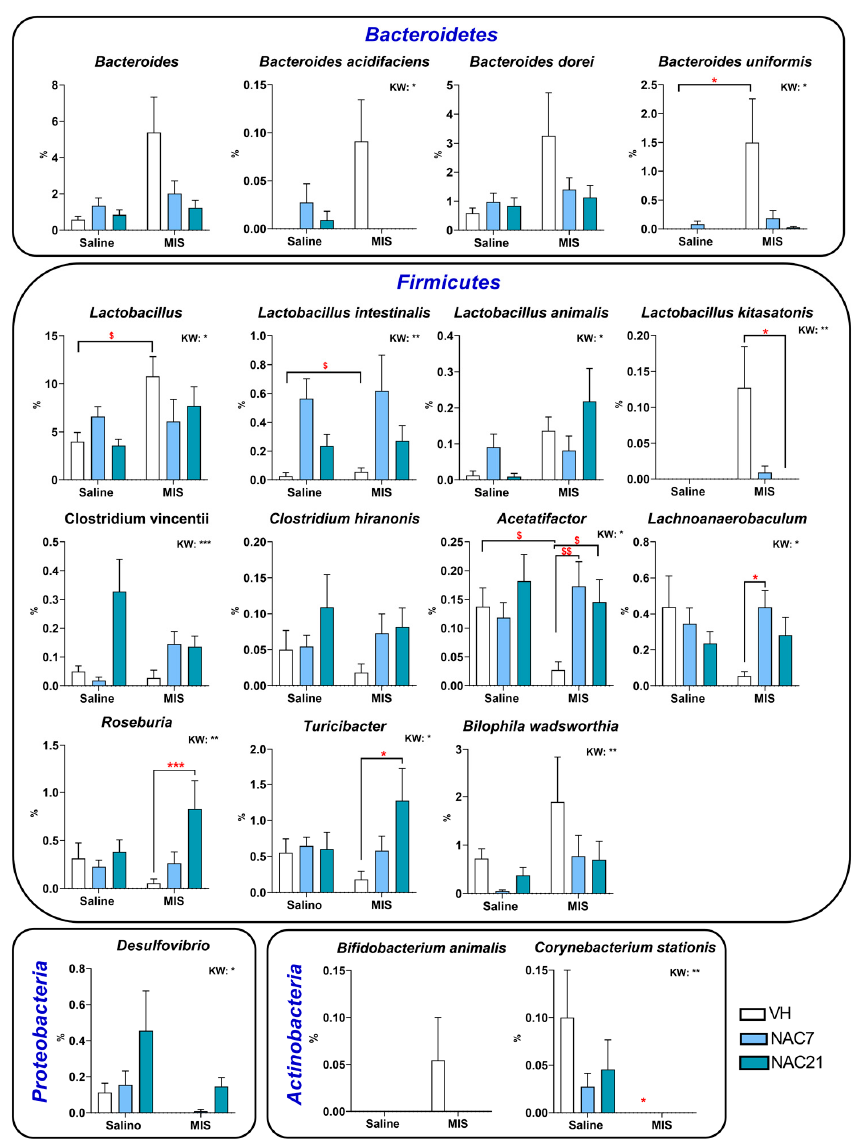
Figure 5. Selection of the most representative genus and species altered in the MIS model and modified by NAC treatment. Each column shows the average of % changes in the composition of microbiota at the genera and species level. Data are shown as mean ± SEM. Kruskal–Wallis (KW) analysis followed by Dunn’s multiple comparison test (* p < 0.05, ** p < 0.01, *** p < 0.001) and Mann–Whitney test ( $ p < 0.05, $$ p < 0.01) are